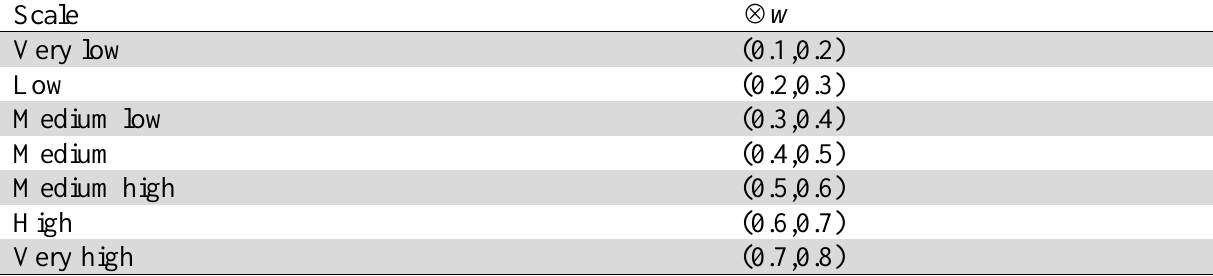
S cale for criteria weights